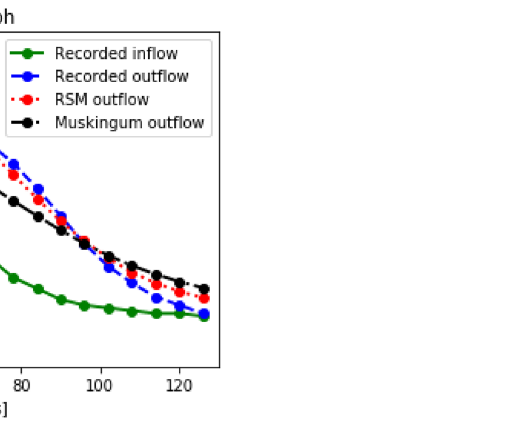
Figure 4. Wilson event: recorded inflow and outflow, reconstructed outflow for the RSM and the Muskingum